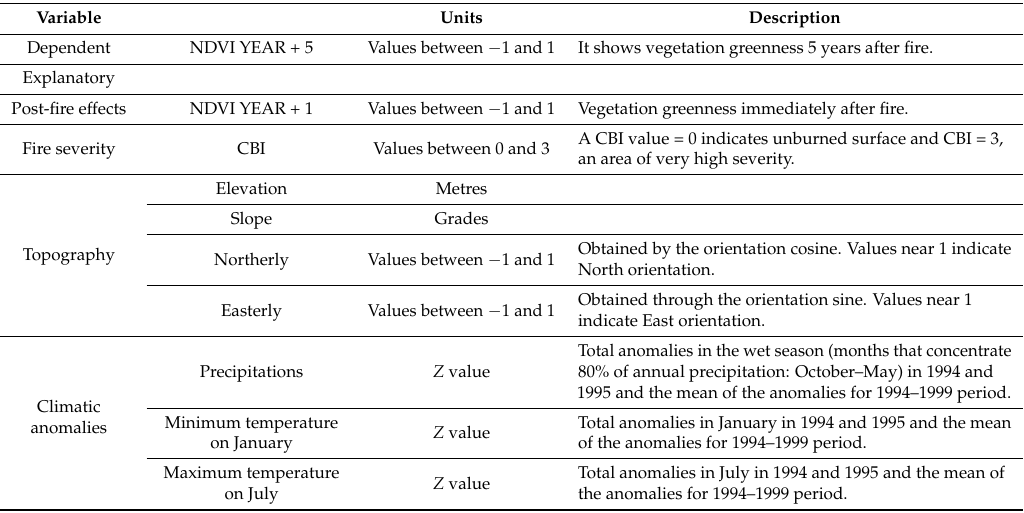
Table 3. List of variables for regression